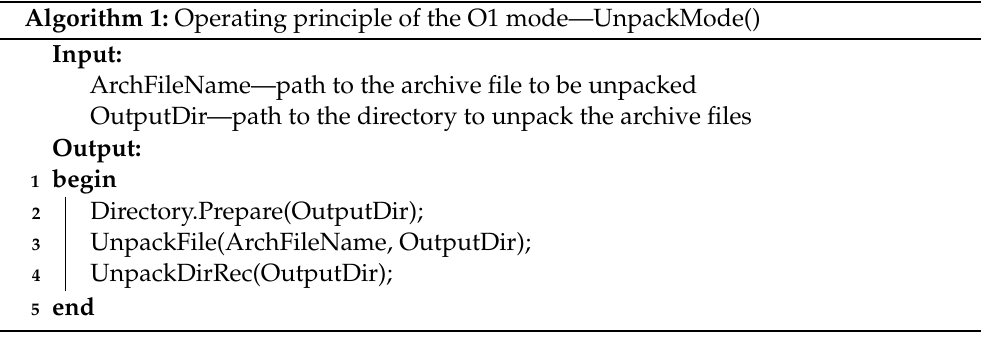
Algorithm 2: Operating principle of the O1 mode—UnpackFile()